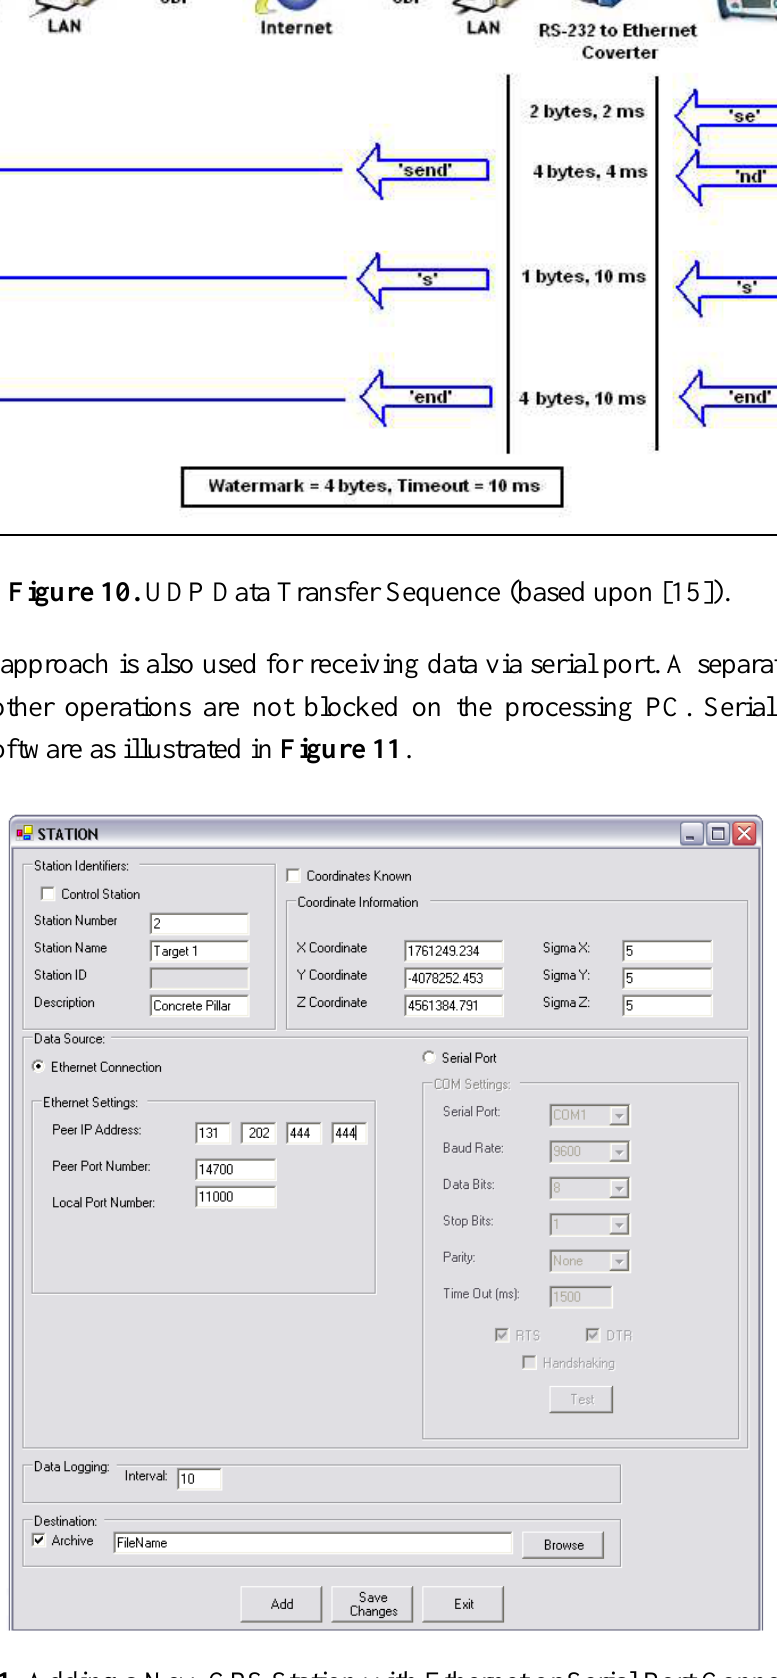
Figure 11. Adding a New GPS Station with Ethernet or Serial Port